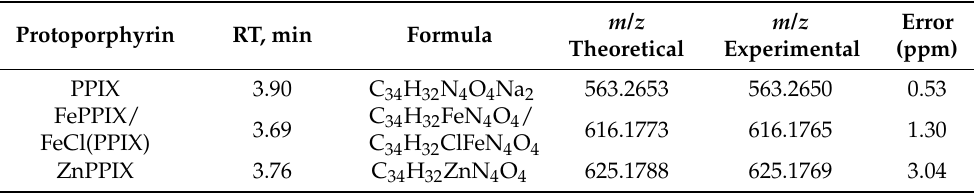
Table 1. Analytical parameters for